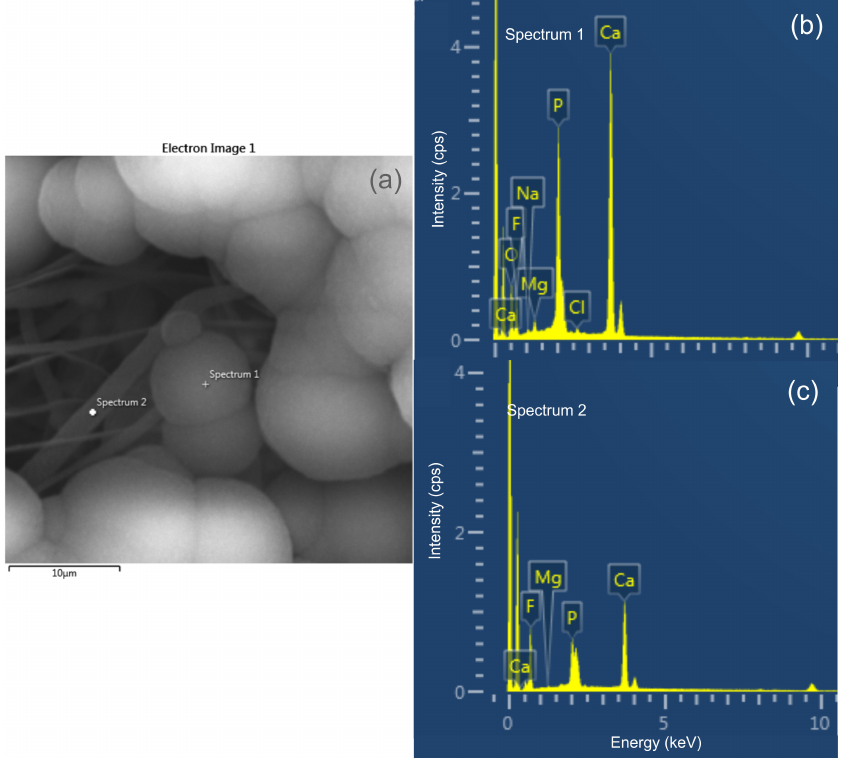
Figure 3. ( a ) SEM image of two different regions: with apatite (Spectrum 1) and without apatite (Spectrum 2) of the P14-H10 scaffold after 21 days of immersion in SBF. ( b , c ) are EDS spectra in the point “Spectrum 1” and “Spectrum 2” of ( a ),